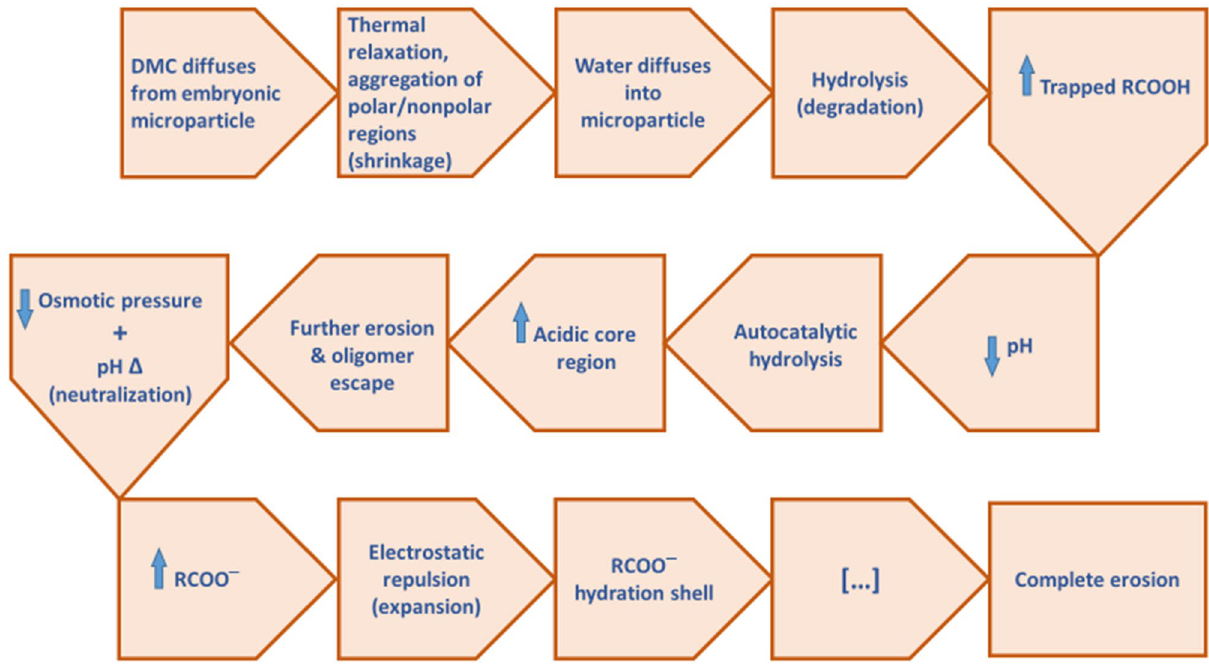
Figure 9. Proposed general course of intermolecular forces behind PLGA microparticle swelling behavior. Arrows represent an increase or decrease of corresponding element and Δ represents